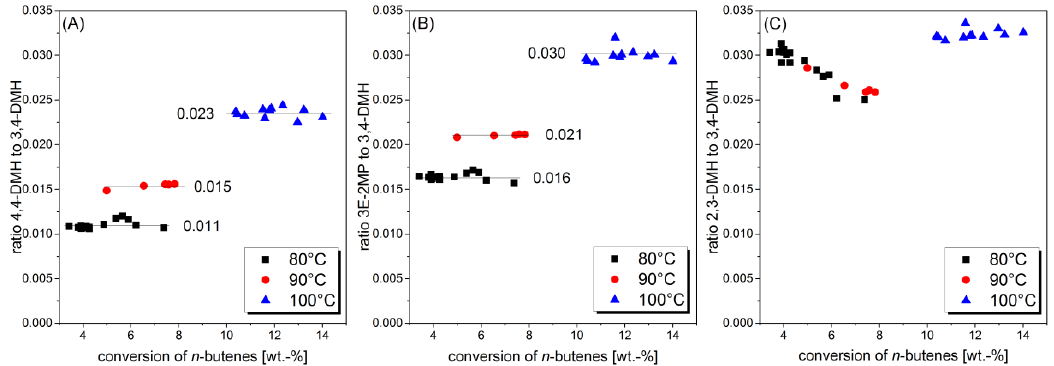
Figure 2. Ratio of octene skeletal isomer after methyl group migration to the main product 3,4- dimethylhexene at different reaction temperatures in differential loop-type reactor for the acid catalyzed conversion of n-butenes; ratio of side products ( A ) 4,4-DMH; ( B ) 3E-2MP; and ( C ) 2,3-DMH to the main product